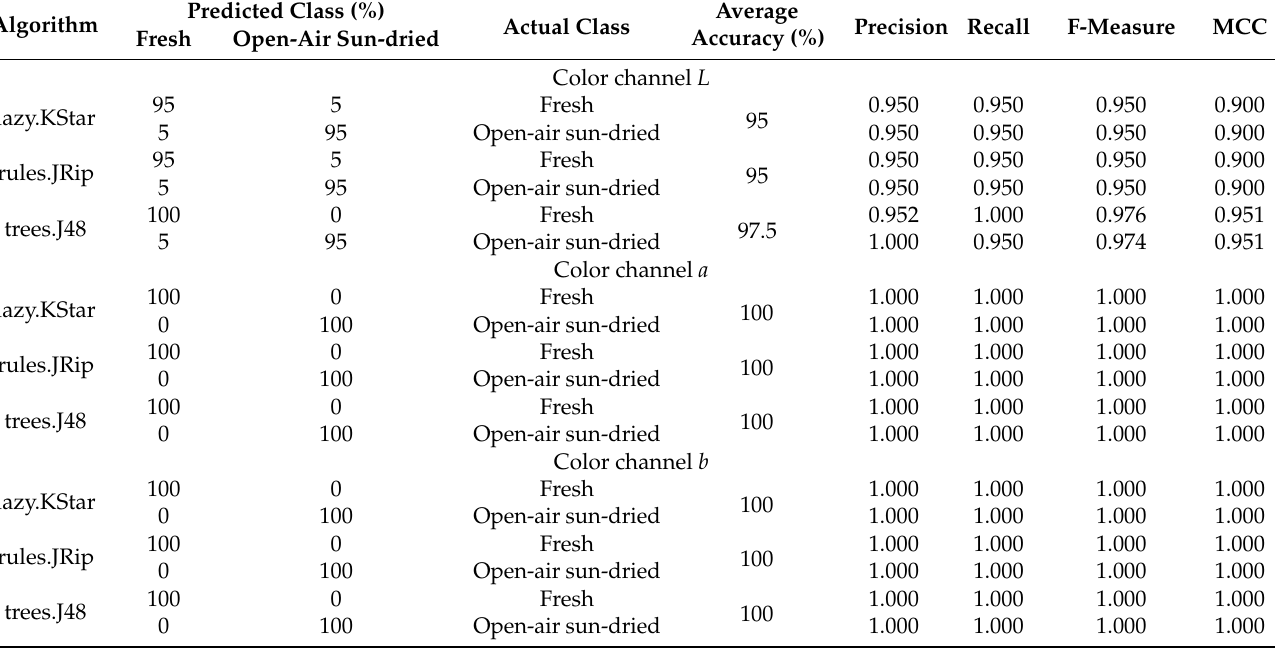
Table 5. The classification of images of the ventral side of fresh and open-air sun-dried mint leaves using models including selected textures from color channels L , a , and b from color space